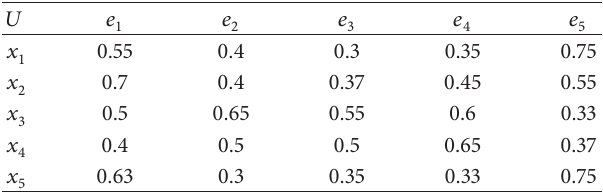
Table 9: The tabular representation of the induced fuzzy soft set Δ ̃𝐹 = (̃Γ, 𝐴) in Example